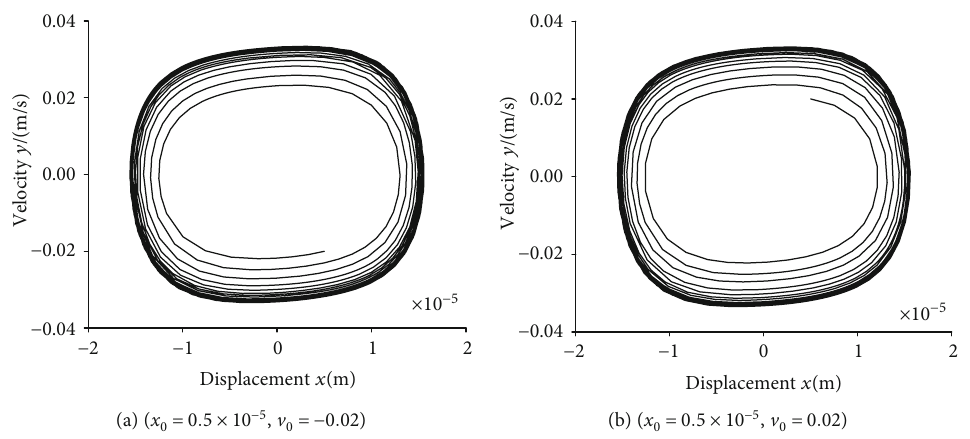
= 1 : 8A , q = 1 : 6 × 10 − 4 m 3 /s . 0 0